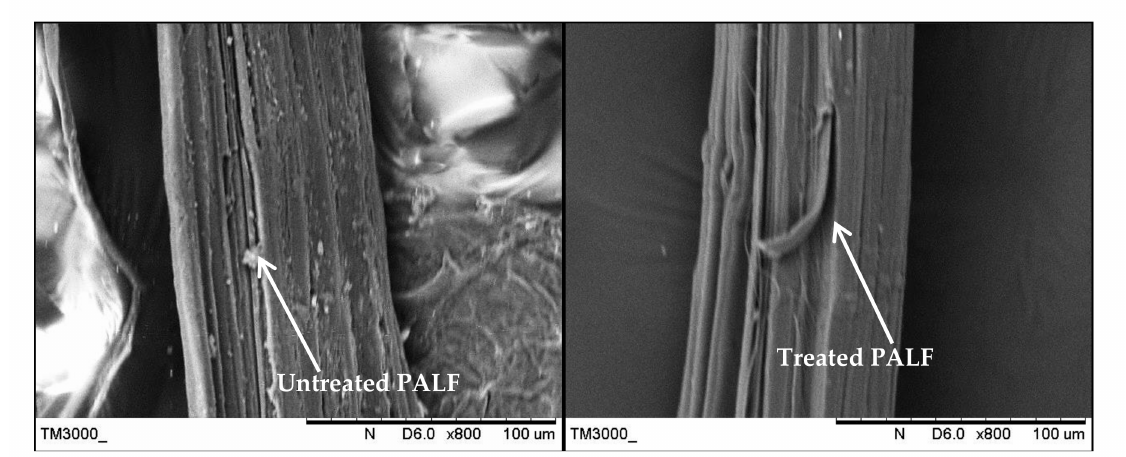
Figure 7. Scanning electron microscopy images of the untreated and treated PALF